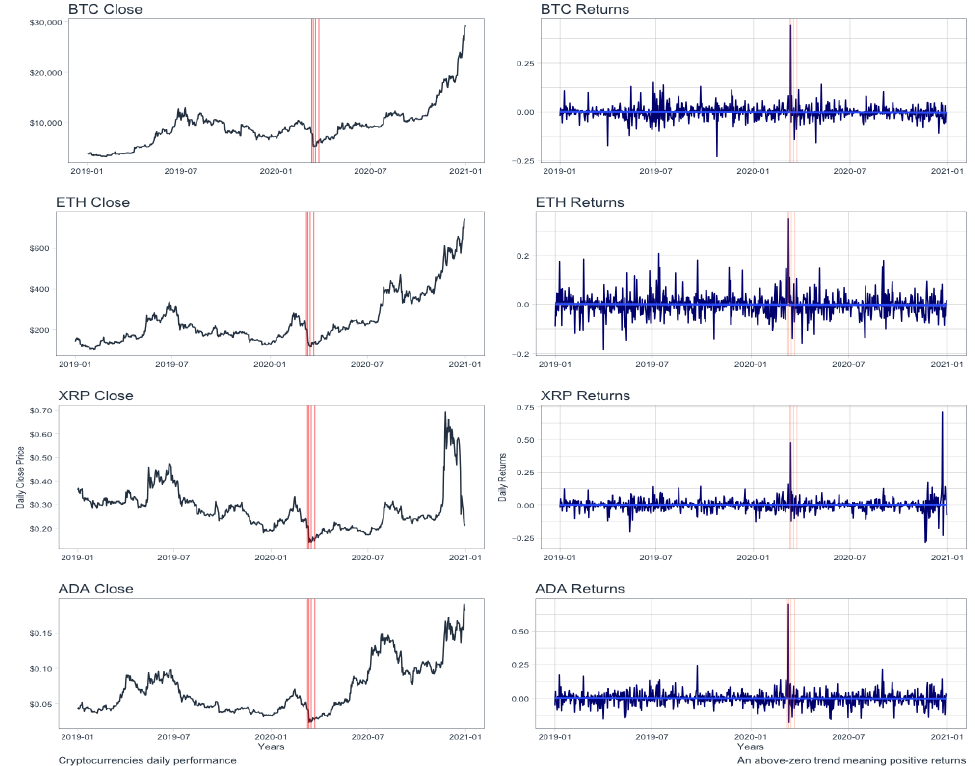
Figure 2. Cryptocurrencies price-performance and returns period January 2019–December